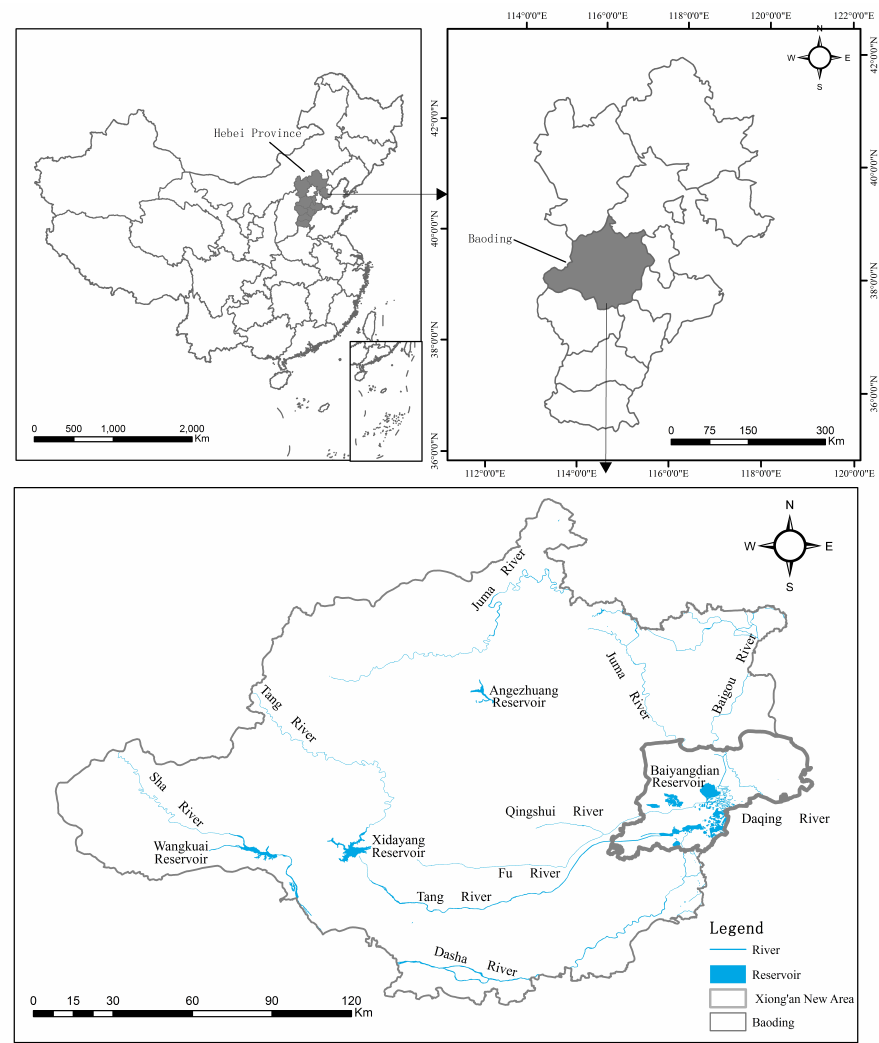
Figure 1. Location of